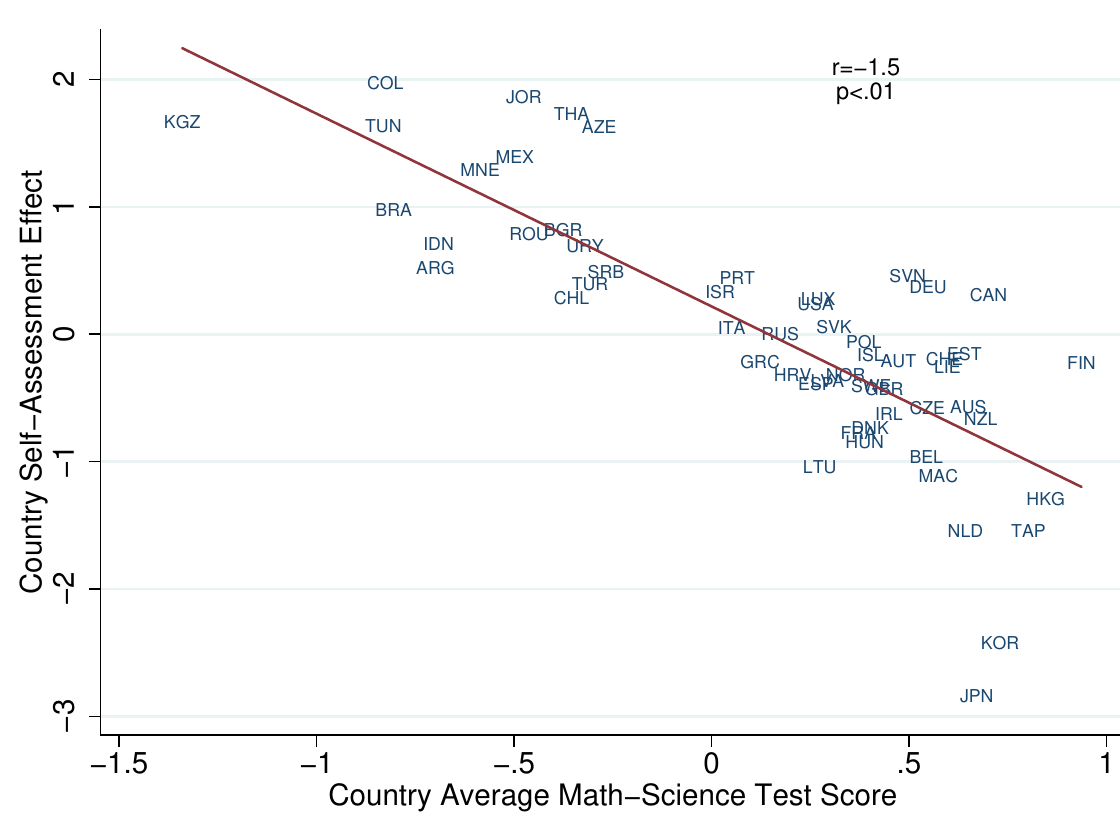
Figure 1: Country self-assessment effect versus country average math and science